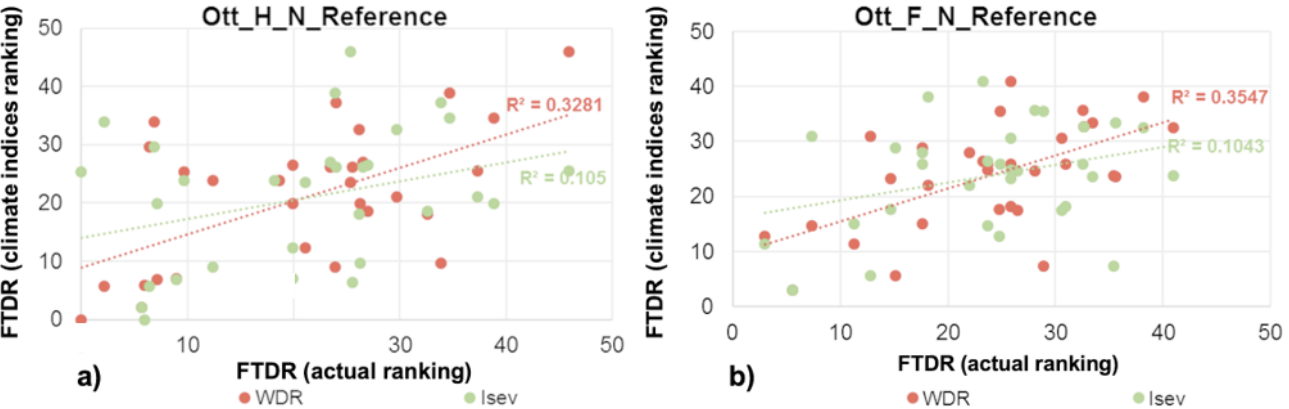
Figure 6. Correlation between FTDR values based on the actual ranking and the climate-based indices ranking of the seasonal period—for a reference wall under ( a ) historical period, and ( b ) future period, facing North orientation in Ottawa.